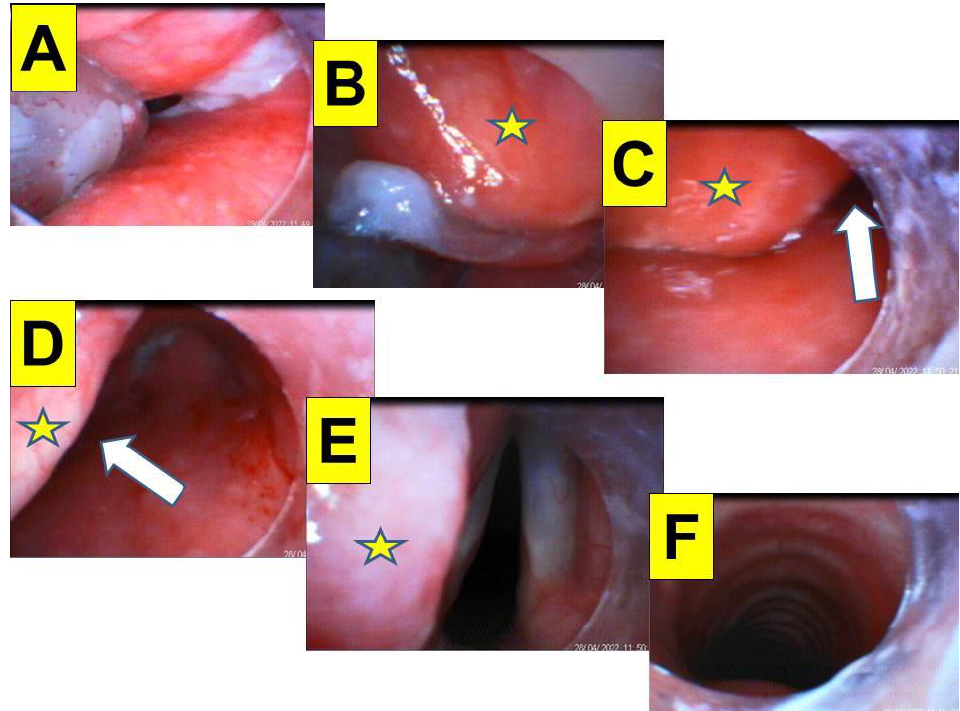
Figure 5. (Case 2) Close-up views during the endotracheal intubation using the video-assisted intubating stylet technique. ( A ) Before reaching the laryngeal inlet, ( B ) jaw-thrust maneuver was not applied, and the dropped epiglottis (denoted by the star) was attached to the posterior pharyngeal wall, ( C ) approaching of the intubating stylet to the glottis was facilitated by maneuvering it through the right side of the space (denoted by the white arrow), ( D ) reverting the stylet to the midline under the dropped epiglottis and directing it to the glottis, ( E ) full glottic visualization, ( F ) entry into the trachea. The intubation process was smooth and took 40 s to complete without the jaw-thrust maneuver. A suction tube was used to remove a copious secretion before the intubation (also see Supplementary Materials, Video